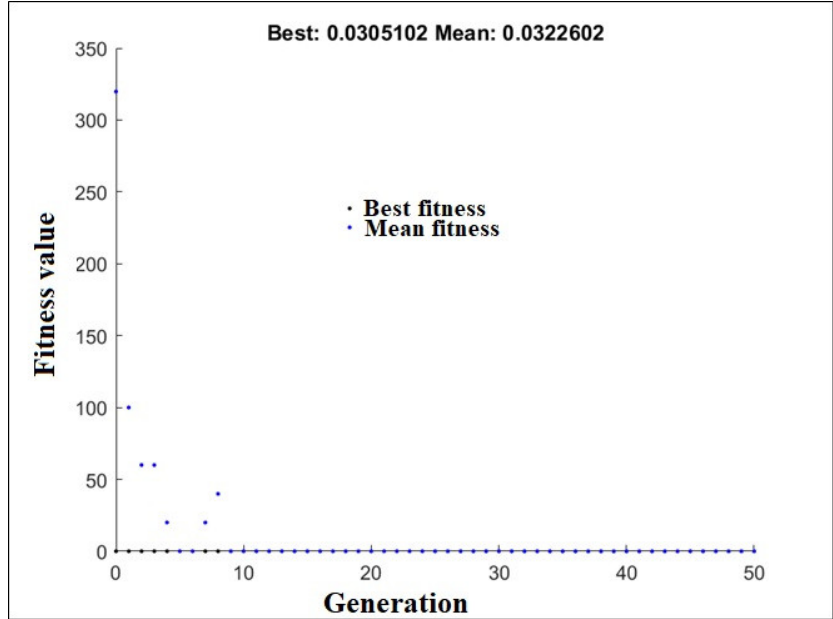
Figure 5. Generation-wise RMSE profile of GA-ANN model.